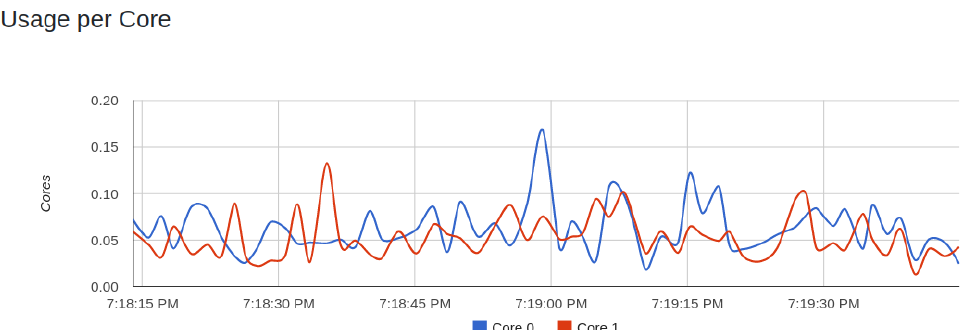
Figure 24. Confirmation of the CPU consumption when the DDoS attack does not occur.